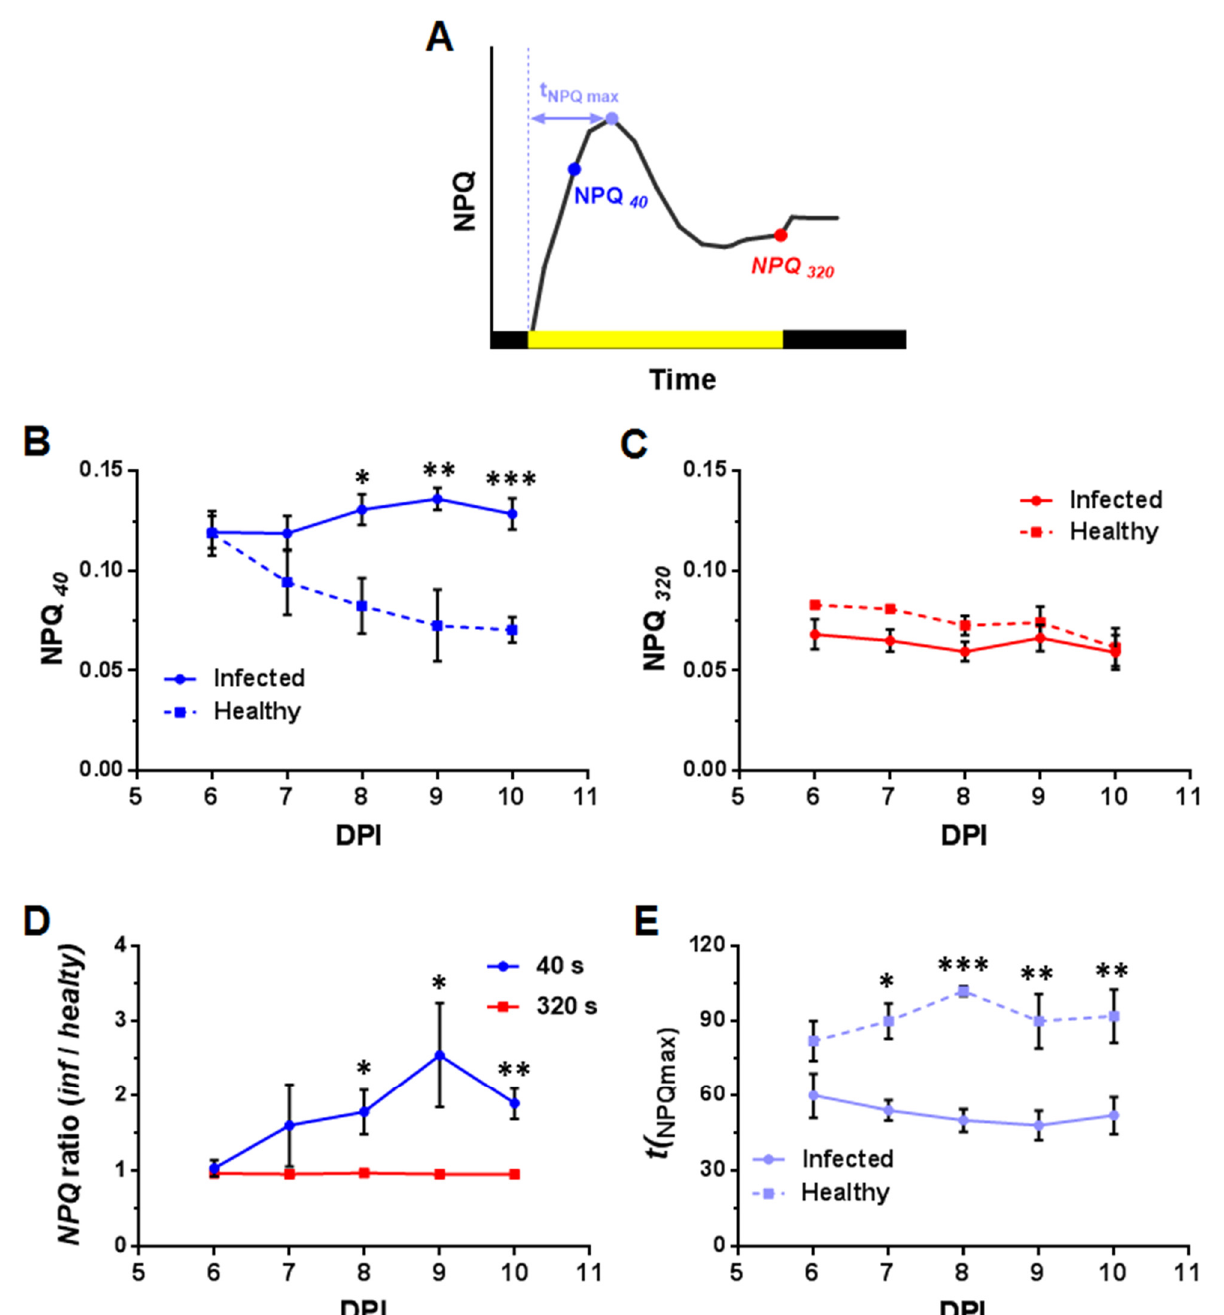
Figure 8. Dynamics of changes in the values of the characteristic parameters of the NPQ light curve depending on the time after inoculation (DPI, day post-inoculation) ( n = 5): ( A ) A diagram showing the characteristic points of the NPQ light curve. Dynamics of the NPQ determined 40 s (NPQ 40 ) ( B ) and after 320 s (NPQ 320 ) ( C ) after the AL was switched on. ( D ) Dynamics of the NPQ ratio in the infected and healthy areas of the leaf. The ratios are calculated for NPQ recorded 40 s (blue curve) and 320 s (red curve) after the AL was switched on. ( E ) Dynamics of the time to reach the maximum NPQ value (t (NPQmax) ); 6 DPI corresponds to the first day of PVX-GFP detection in the studied leaf. Values are mean ± SEM. *, **, *** indicate statistically significant differences between the values in the infected and healthy areas or the differences in the ratios from 1 ( p < 0.05, 0.01 and 0.001,